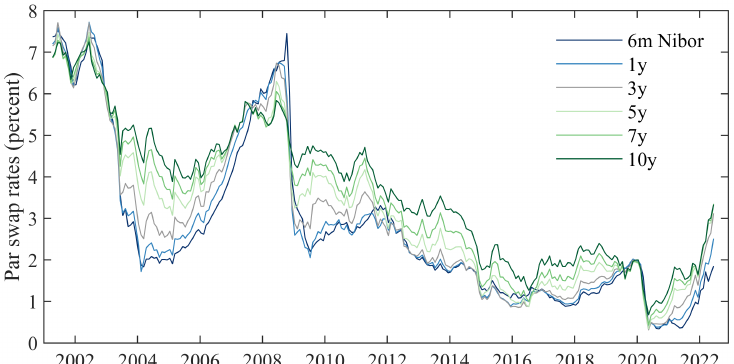
Figure 1. NOK interest rate swap rates vs. 6 m Nibor, retrieved from Bloomberg. Sample period: 2001/04 to 2022/06.